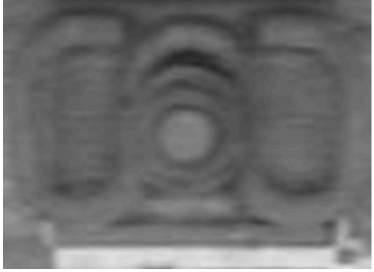
Figure 12. Simulation of an image with a motion blur.